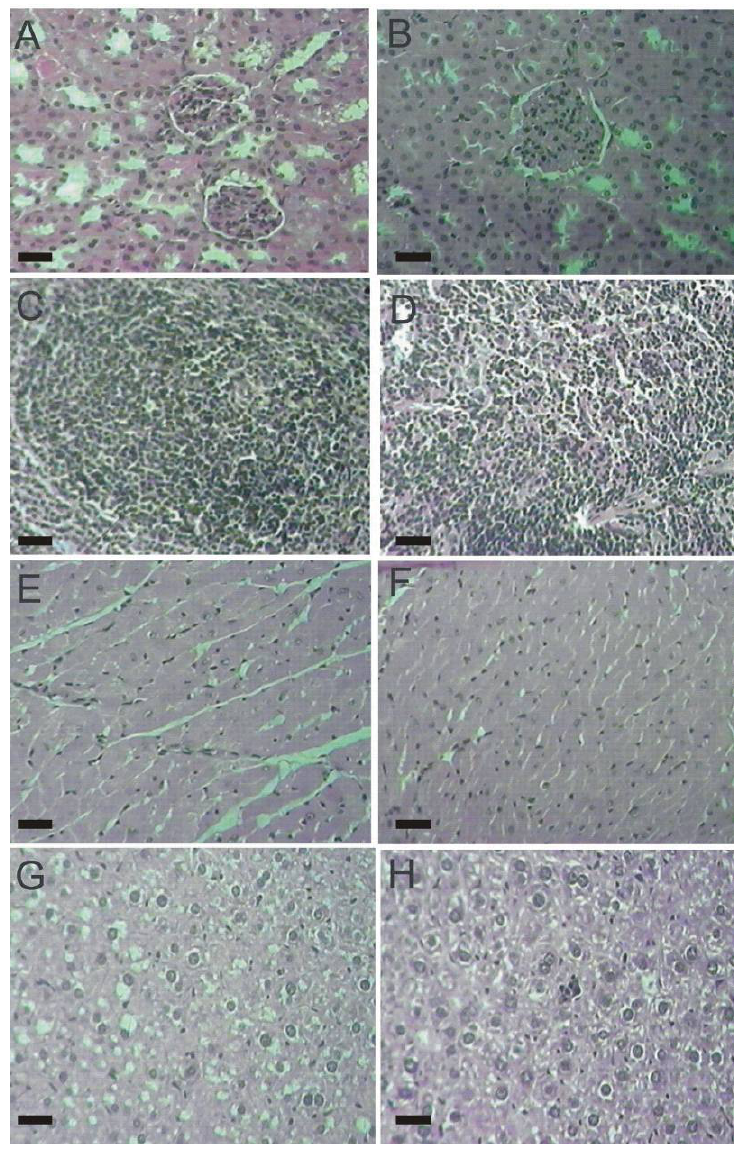
Figure 5. Histological tissue sections from female mice (100×). ( A ) kidney from the control group; ( B ) kidney from the lasiodiplodan-treated group; ( C ) spleen from the control group; ( D ) spleen from the lasiodiplodan-treated group; ( E ) heart from the control group; ( F ) heart from the lasiodiplodan-treated group; ( G ) hepatic tissue from the control group; and ( H ) hepatic tissue from the lasiodiplodan-treated group. Scale bar 25